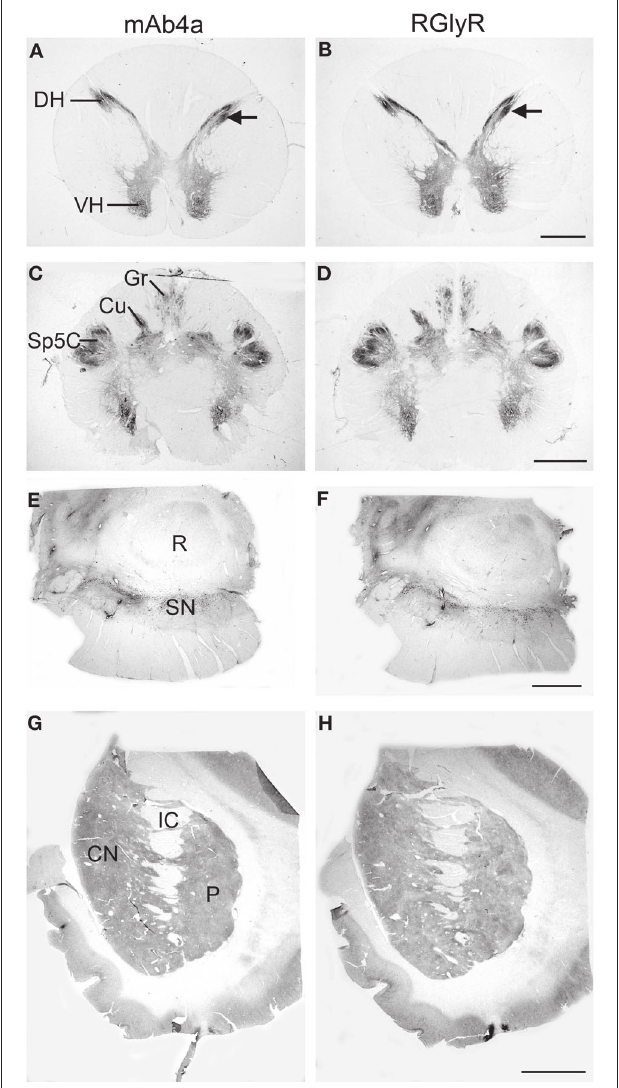
FIGURE 1 | Regional localization of glycine receptors at the cervical level of the human spinal cord (A,B), pyramidal decussation in the lower medulla oblongata (C,D), substantia nigra (E,F) and basal ganglia at the level of the caudate-putamen (G,H) visualized by DAB staining of adjacent sections using monoclonal antibody mAb4a (A,C,E,G) and rabbit polyclonal antibody AB5052 (B,D,F,H). (A,B) Light macroscopic images of sections of the fi rst cervical segment of the spinal cord stained for GlyR with mAb4a (A) and AB5052 (B) antibody showing especially intense labeling in lamina II of the dorsal horn (DH) and moderate to high levels of GlyR-IR in the gray matter of the ventral horn (VH) and dorsal horn. (C,D) Macroscopic images of sections of the pyramidal decussation stained for GlyR with mAb4a (C) and AB5052 (D) antibody revealing patchy GlyR-IR in the gracile nucleus (Gr) and the cuneate nucleus (Cu) and intense GlyR-IR in the spinal trigeminal nucleus (Sp5C). (E,F) Macroscopic images of sections of the substantia nigra (SN) stained for GlyR with mAb4a (G) and AB5052 (H) antibody showing high levels of GlyR-IR in the regions of the substantia nigra pars compacta and the substantia nigra pars reticulata. (G,H) Macroscopic images of sections of the basal ganglia at the level of the caudate-putamen stained for GlyR with mAb4a (E) and AB5052 (F) antibody suggesting a heterogeneous distribution of GlyR in the caudate nucleus (CN) and putamen (P) separated by the internal capsule (IC). Scale bar = 2 mm in (A , B) ; 2.5 mm in (C,D) ; 0.5 cm in (E–H)